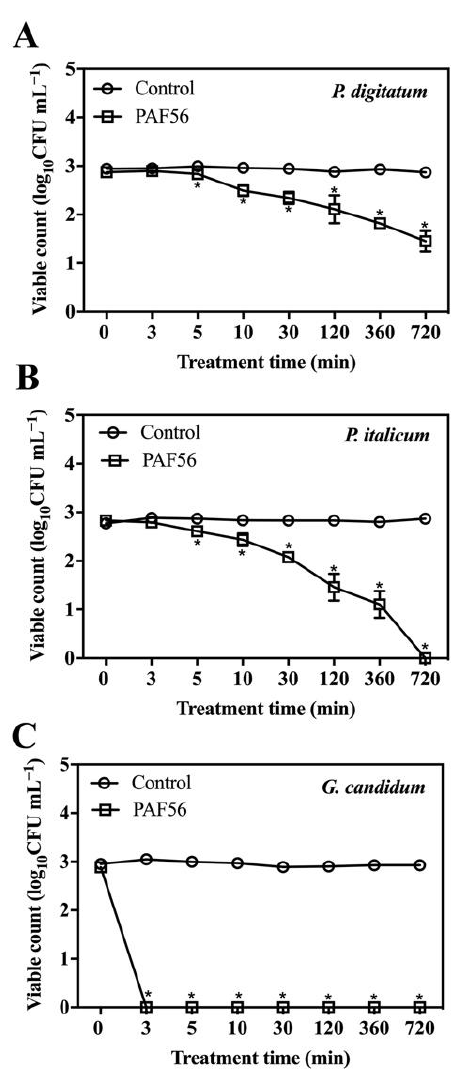
Figure 5. Time–kill kinetics of peptides PAF56 against P. digitatum ( A ), P. italicum ( B ), and G. candidum ( C ) spores. Spores (10 3 CFU mL − 1 ) were mixed with PAF56 (64 µ mol L − 1 ) in sterile distilled water. Group without the use of peptide was the control group. Samples of 50 µ L were spread onto PDA plates at each time point after incubation. The CFU was counted after the plates were incubated for 48 h at 25 ◦ C. Vertical bars indicate the standard error of the means. The mark * represents the significant differences ( p < 0.05) between PAF56 and the control group.